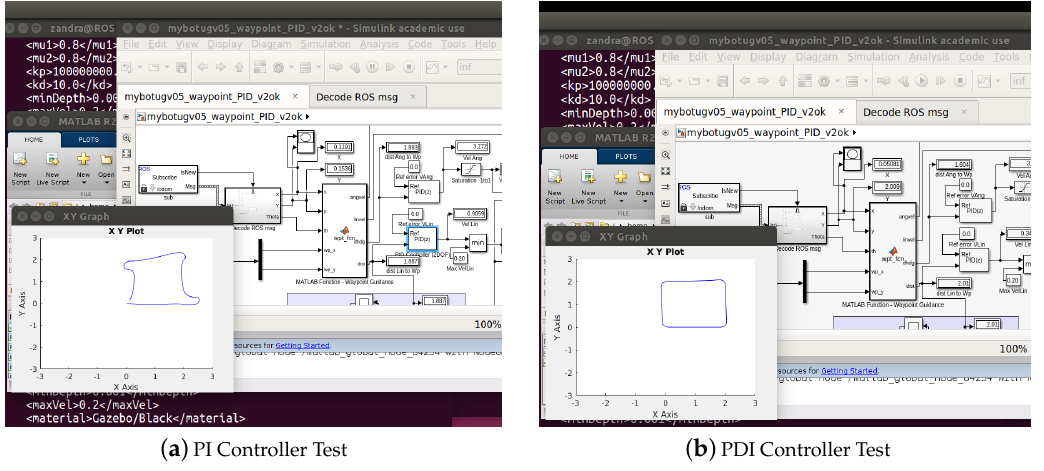
Figure 8. Waypoint navigation tests for the optimization of the control system developed in a Matlab-Simulink